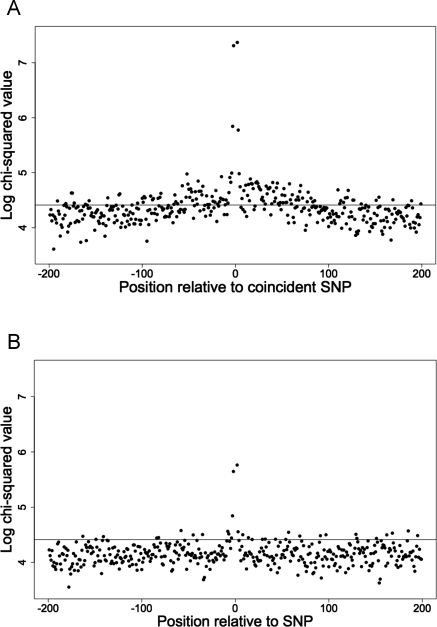
Heterogeneity in Triplet FrequenciesThis figure gives the log value from a chi-square test of heterogeneity of triplet frequencies at each site of the human–chimpanzee alignment versus the average triplet frequencies across the whole alignment for (A) alignments containing a coincident SNP, and (B) alignments without a coincident SNP, but with a chimpanzee SNP at the central position. The line marks the point above which 5% of the chi-square values are expected to fall by chance alone. The chi-square values are not given for the central three sites because the presence of the chimpanzee SNP in the centre of the alignment means that triplets cannot be counted at positions 0, +1, and −1.